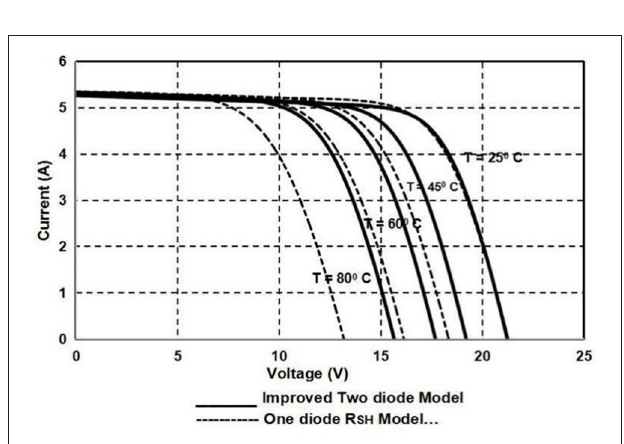
FIGURE 11 | Comparative analysis of current (A) vs. voltage (V) curve for one-diode R SH and proposed two-diode model for DS-A1-80 with different temperature points at STC (1,000 KW/m 2